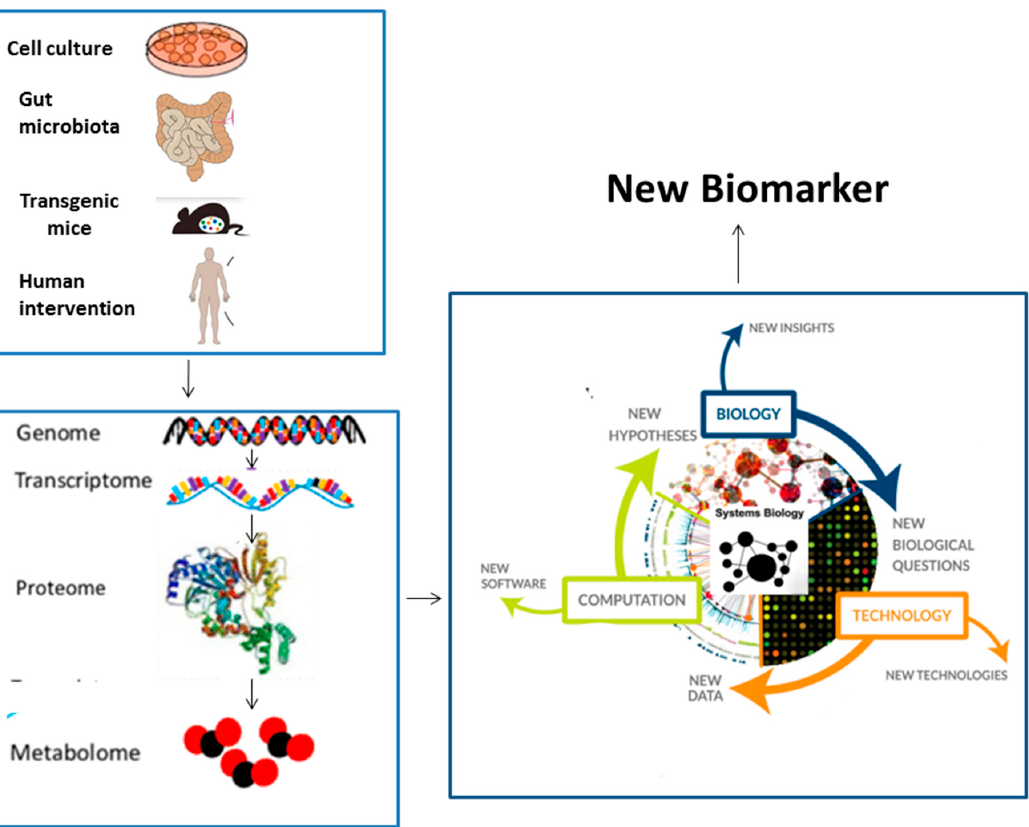
Figure 2. The role of systems biology in biomarkers, from the identification of a gene via human profiling towards systems biologic approaches in the identification of biomarkers.